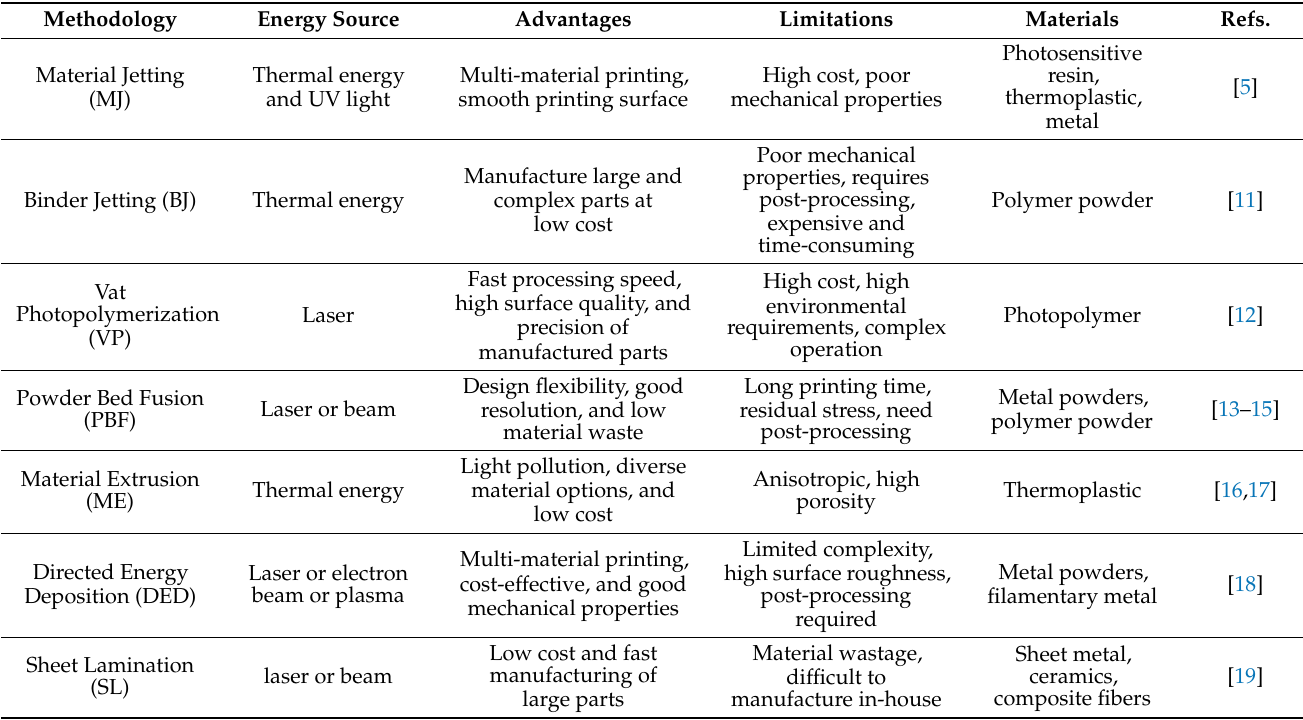
Table 1. Advantages and disadvantages of additive manufacturing processes and commonly used materials in tissue